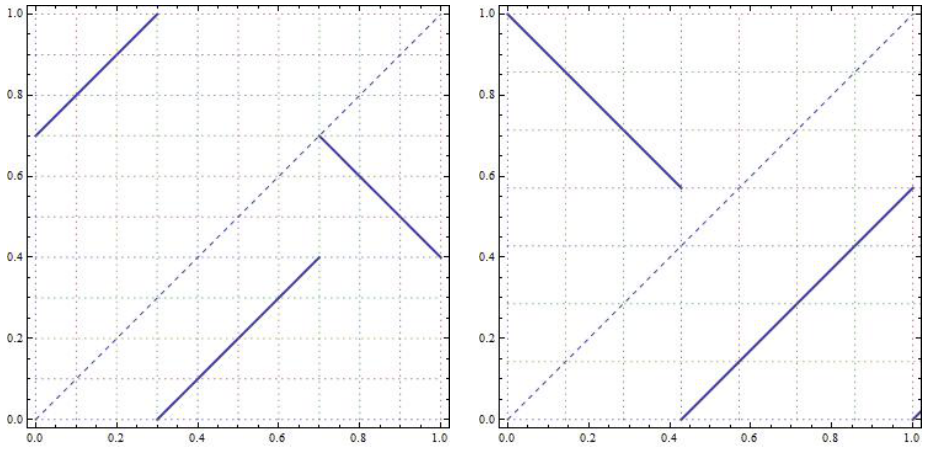
Figure 1. Graph of a ( 3,1 ) -IET with permutation ( 3,1, − 2 ) and a = 0.3 ( left ). On the ( right ), the graph of the Poincaré